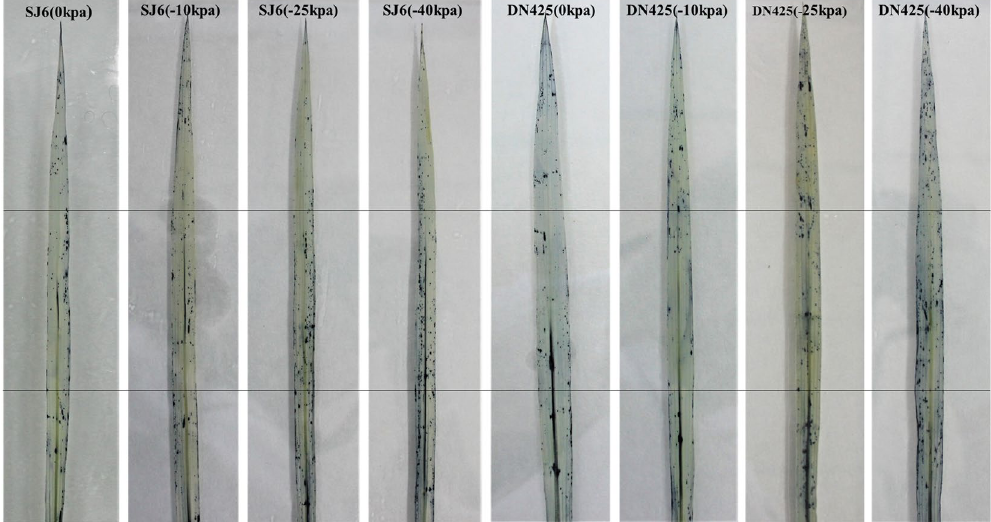
in top leaf at tillering stage of two rice cultivars in all treatments 2